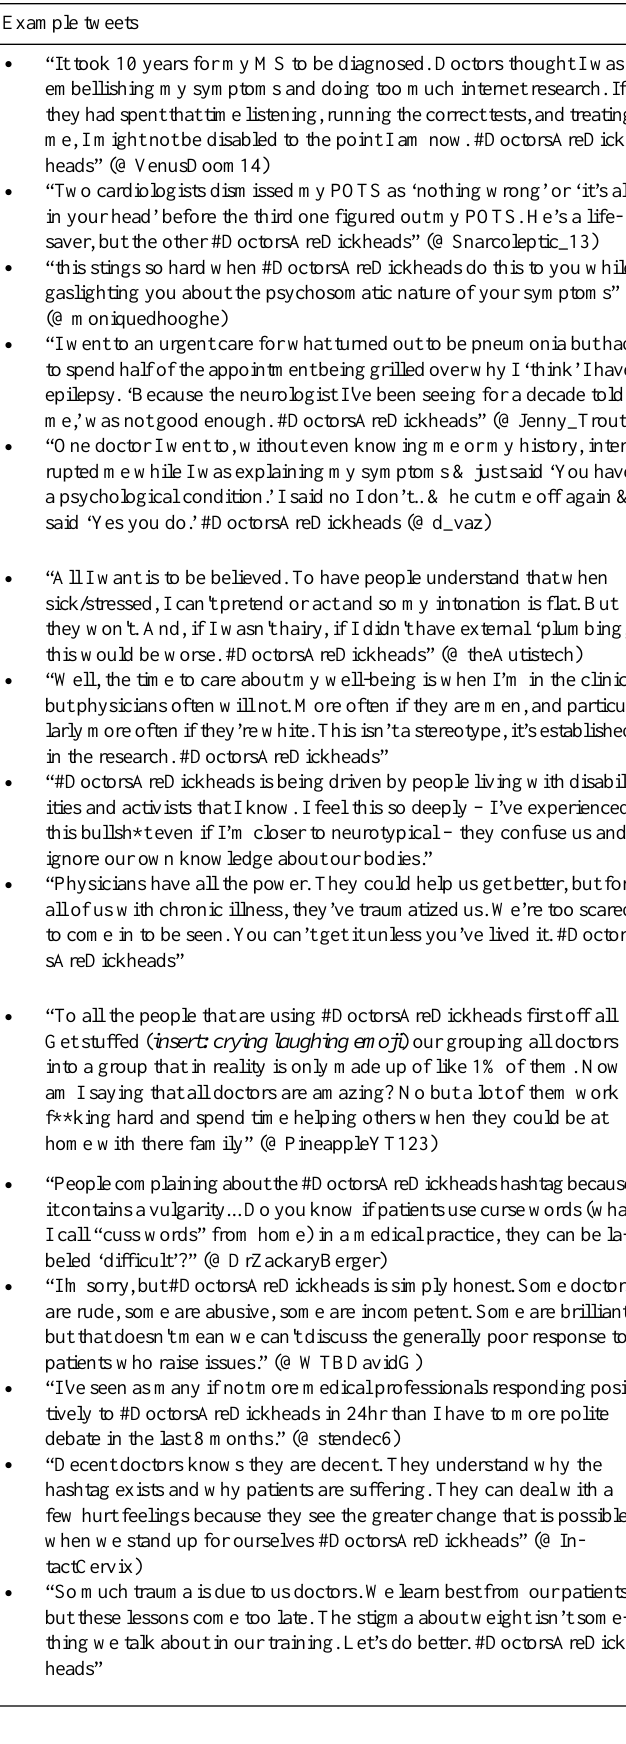
Table 3. Major themes and definitions identified in the content analysis of the Twitter hashtag.